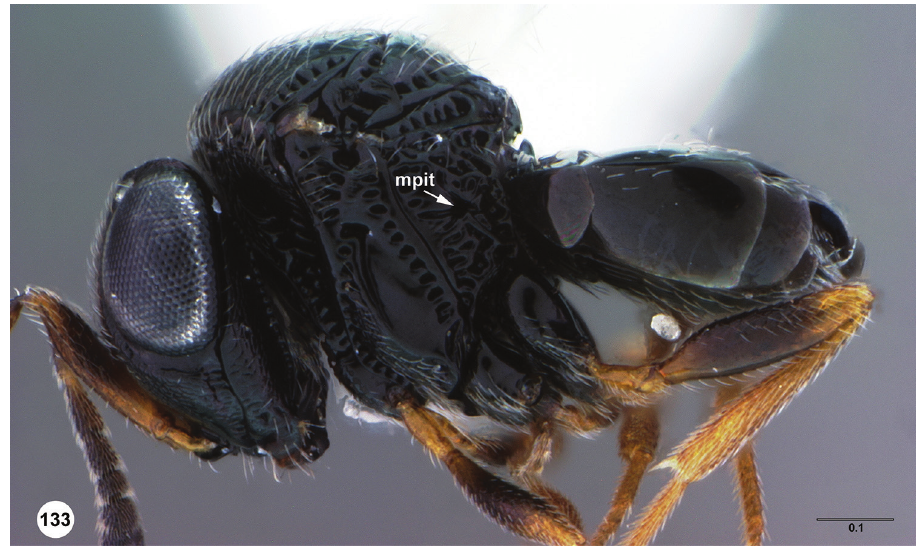
Figure 133. Trissolcus plautiae female (USNMENT00916880), head, mesosoma, metasoma, lateral view. Scale bars in